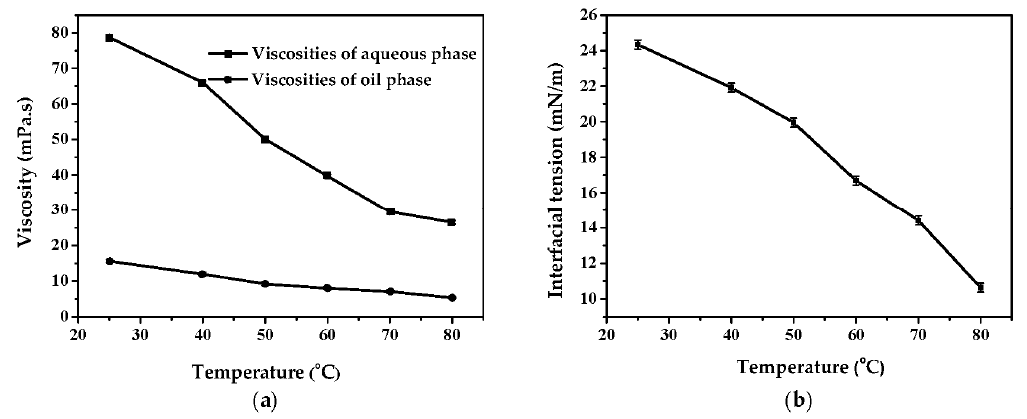
Figure 11. The viscosities of oil (LP/EP, 11/1 ( w / w )) and aqueous phases (KGM I) and the interfacial tension between oil phase and aqueous phases at different temperatures. ( a ) Viscosities of oil and aqueous phases at different temperatures; ( b ) Interfacial tensions between oil and aqueous phases at different temperatures.